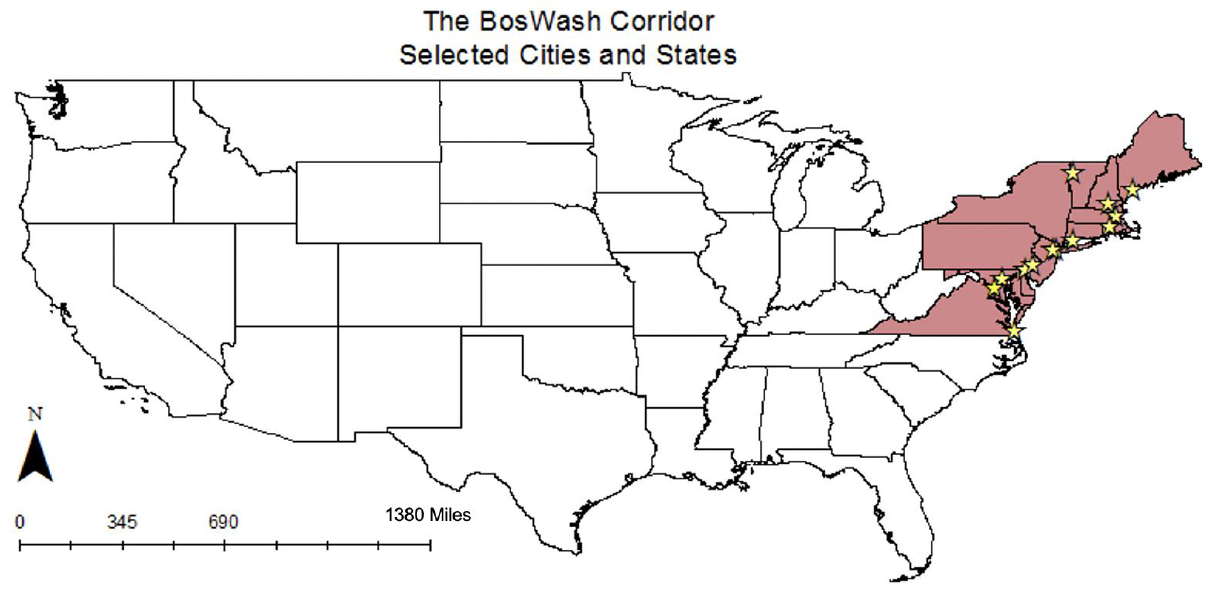
Figure 2. Selected states and major cities considered in the BosWash corridor. Selected states highlighted in red and selected cities noted by yellow stars.